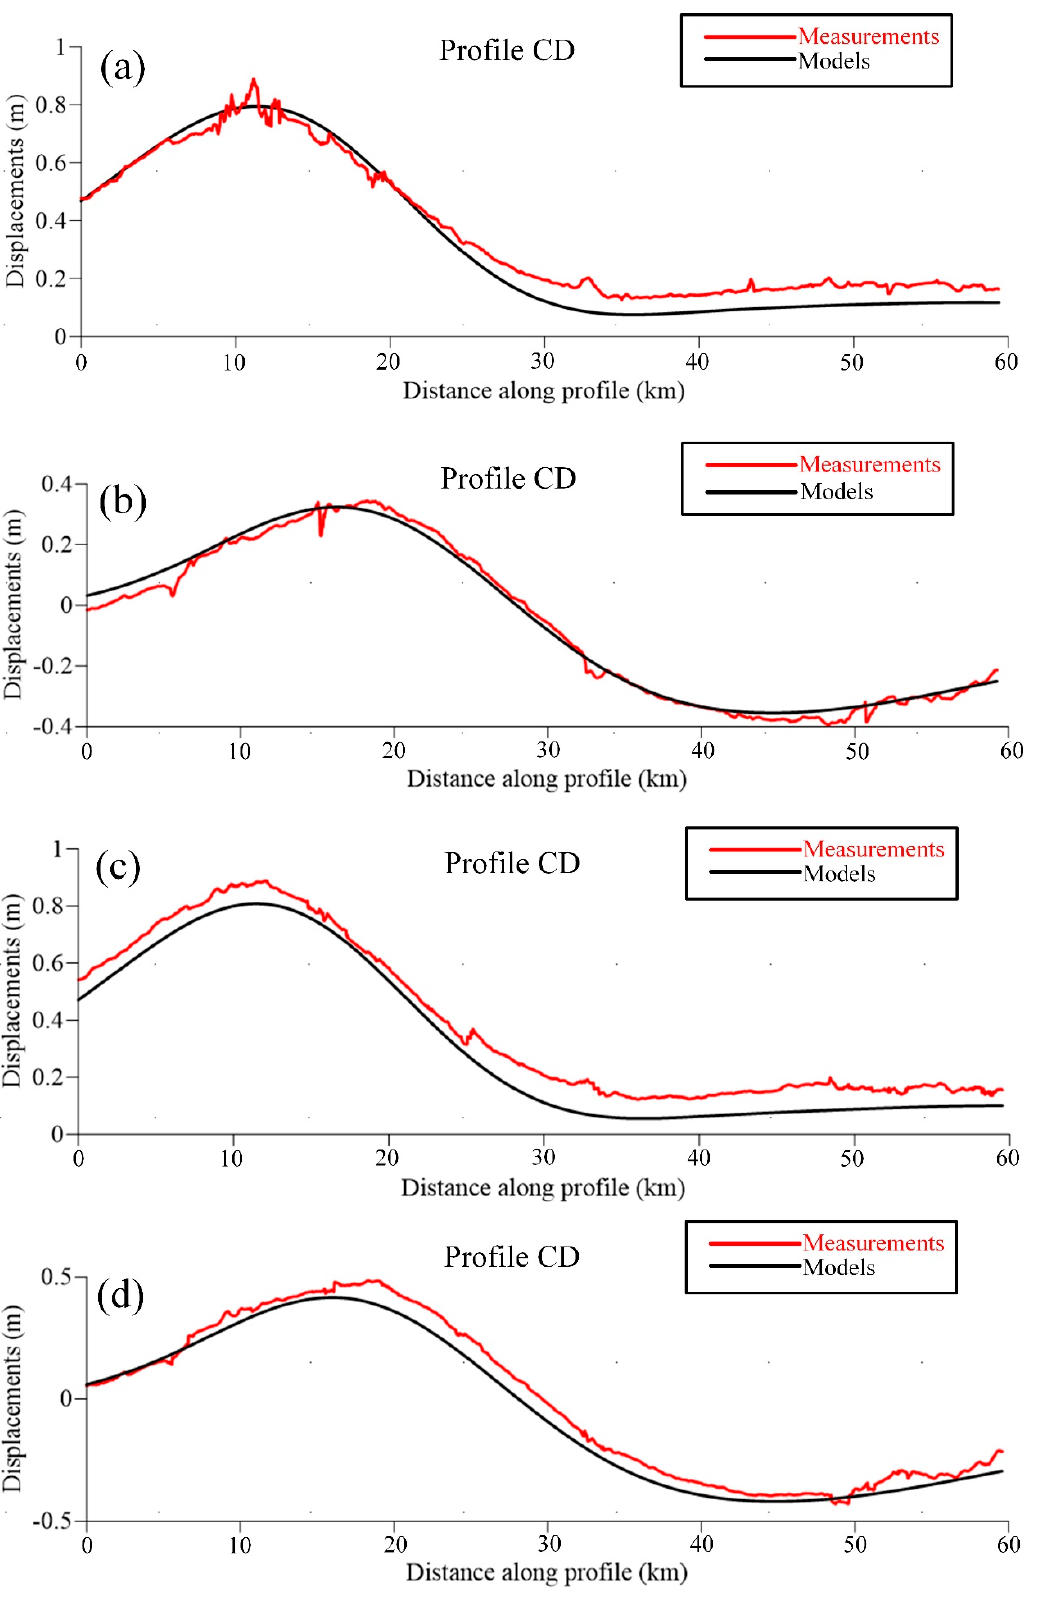
Figure 8. The displacements along the profile CD. ( a , b ) correspond the profile CD in Figure 7a,b and Figure 7d,e, respectively. ( c , d ) correspond the profile CD in Figure 7g,h and Figure 7j,k, respectively.